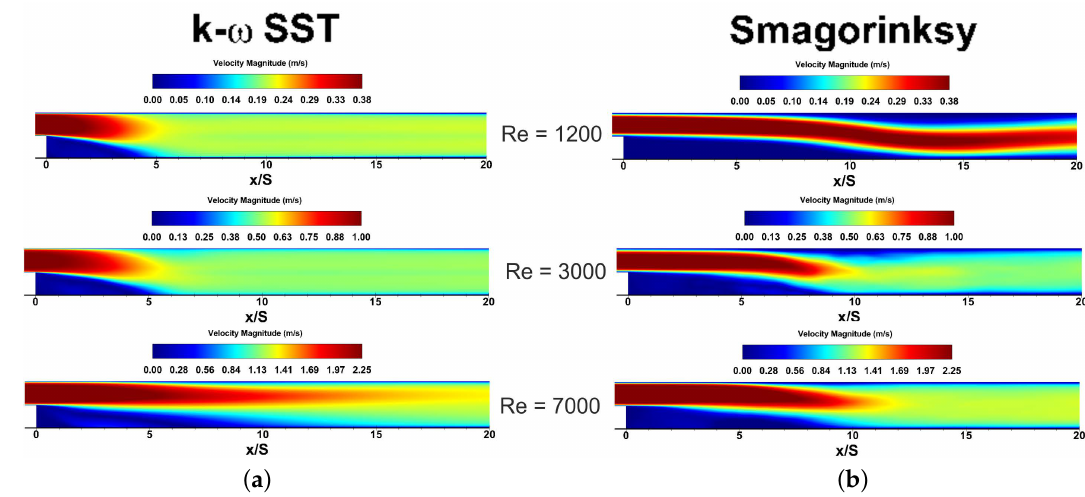
ω SST model ( a ) and Smagorinsky −